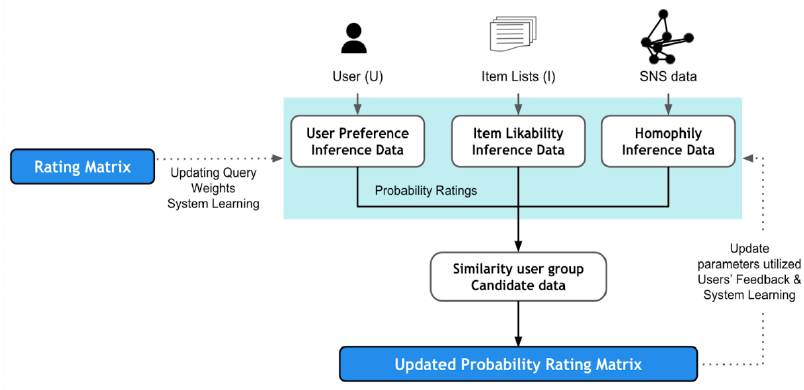
Figure 17. Hybrid recommendation overview of overall social network service.